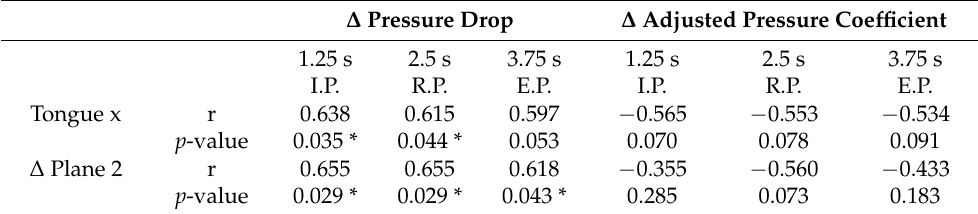
Table 6. Correlation between the surgical changes and airflow characteristics.